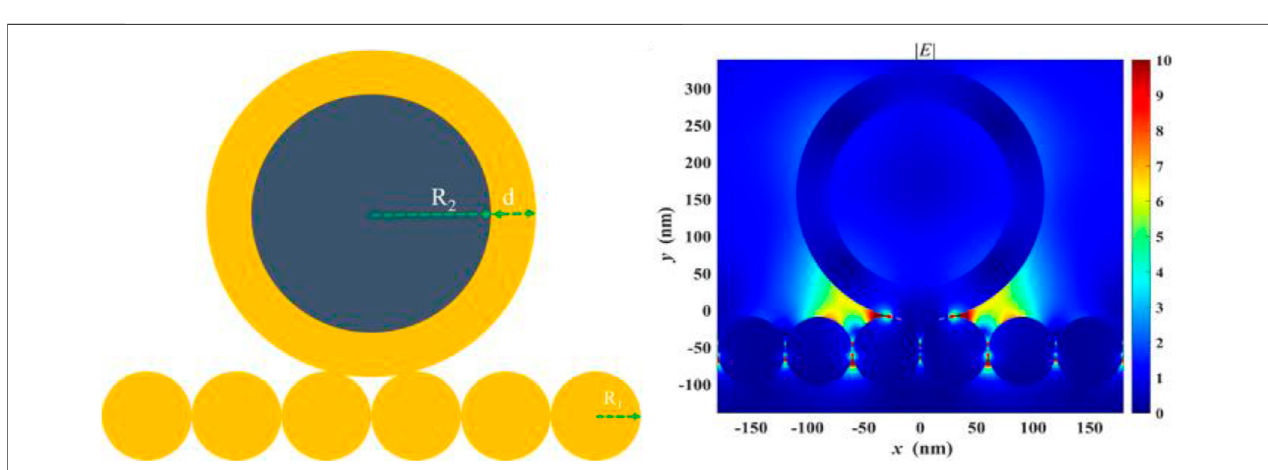
FIGURE4| Finite-differencetime-domain(FDTD)analysisshowingenhancedelectromagnetic(EM) fi eldinbetweenthegapformedbytheAu@MNPandtheliquid- state SERS substrate.